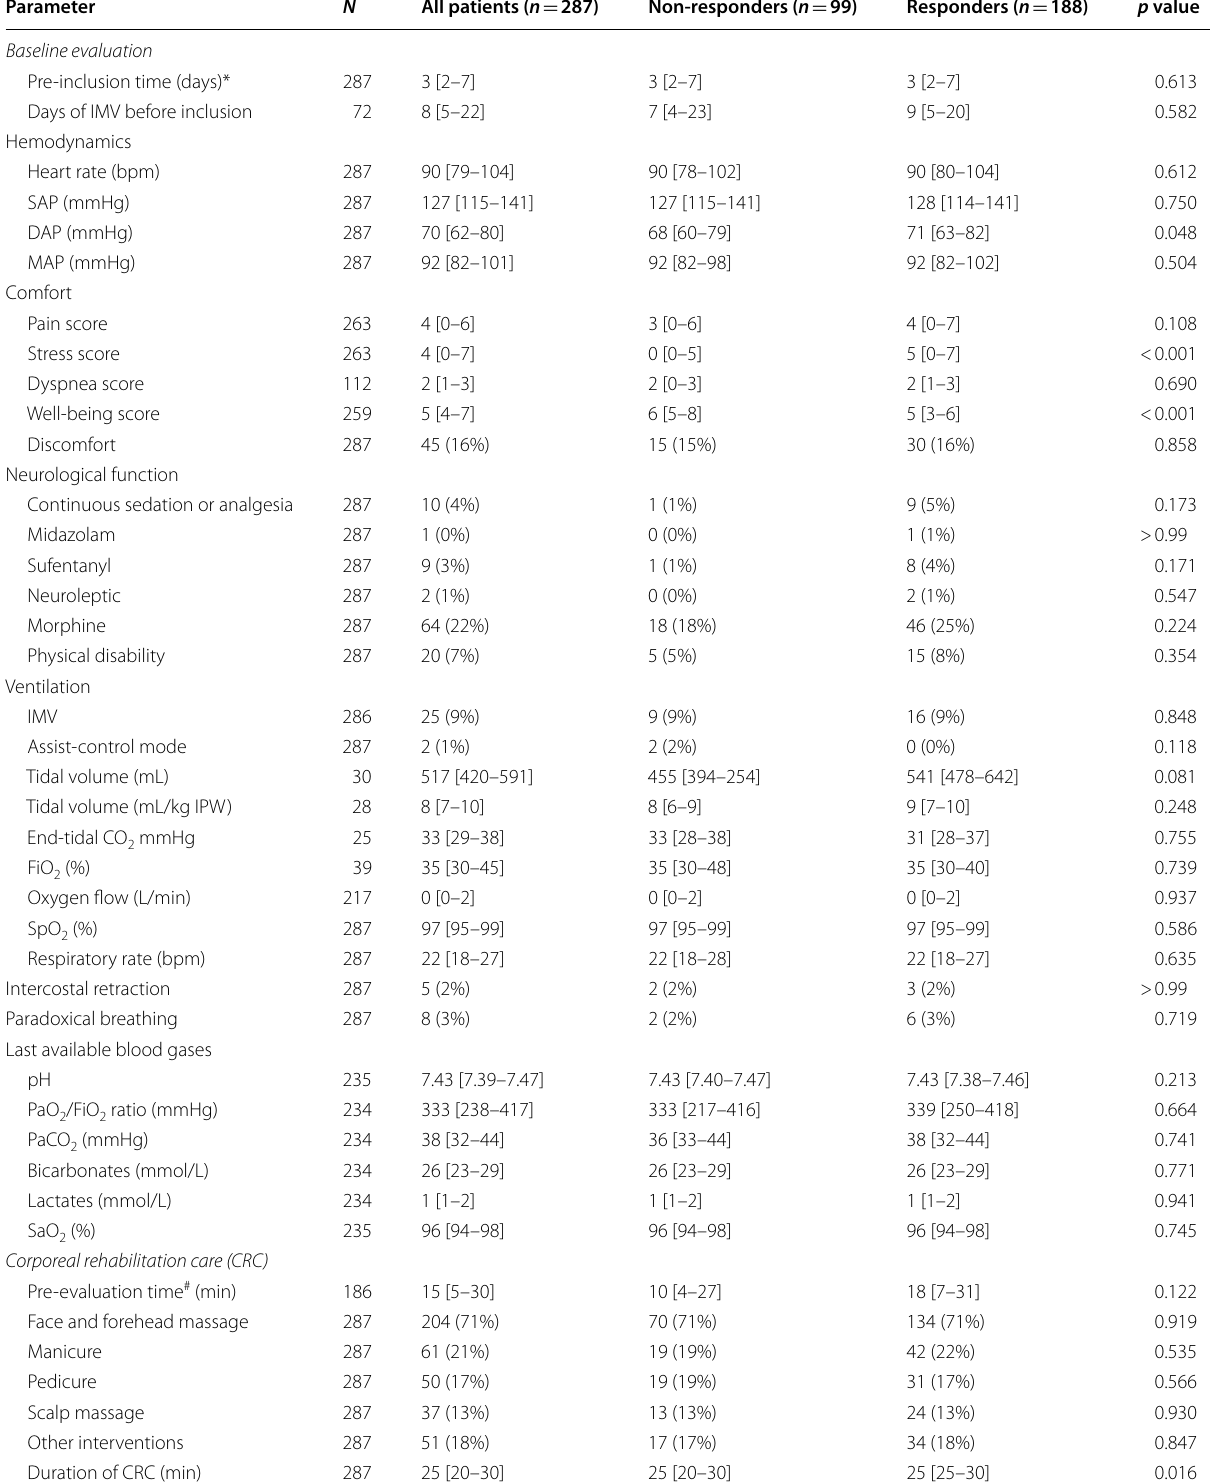
Table 3 Baseline evaluation, direct and remote assessment in critically ill patients, overall and depending on their response